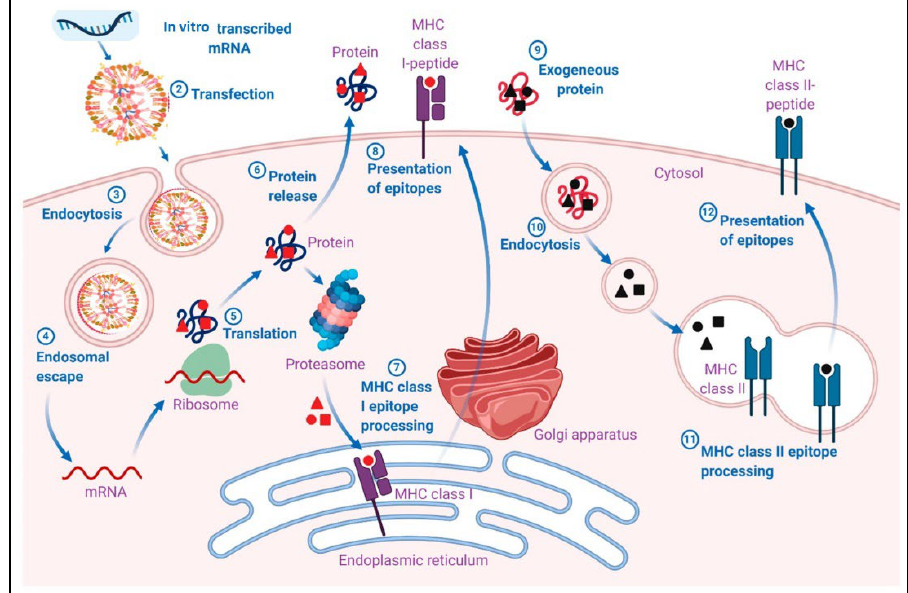
Figure 3. Pharmacological mechanism of adaptive immune responses induced by mRNA-LNP vaccines. (1) In vitro transcribed mRNA is encapsulated into a lipid nanoparticle (LNP). (2) Transfection of mRNA-LNP vaccine molecules into the host cells, using specialized lipids on the surface of the LNPs. (3) Endocytosis of mRNA-LNP. (4) Endosomal escape of mRNA to the cytosol after endocytosis-mediated internalization. (5) Translation of the mRNA by the host cell ribosomes into the desired antigen protein intracellularly. (6) Antigenic protein released outside the cell, or the antigenic protein is degraded by a proteosome, exposing the antigenic sites. (7) Major histocompatibility complex I (MHC I) epitope presentation of the MHC I to the cell membrane for antigen presentation (APC). MHC I presents the epitope to CD8+ T cells. (9) The exogenous protein released earlier can get degraded and presented via MHC II epitopes. The extracellular antigen can get recognized by B cells, leading to B cell maturation [25].